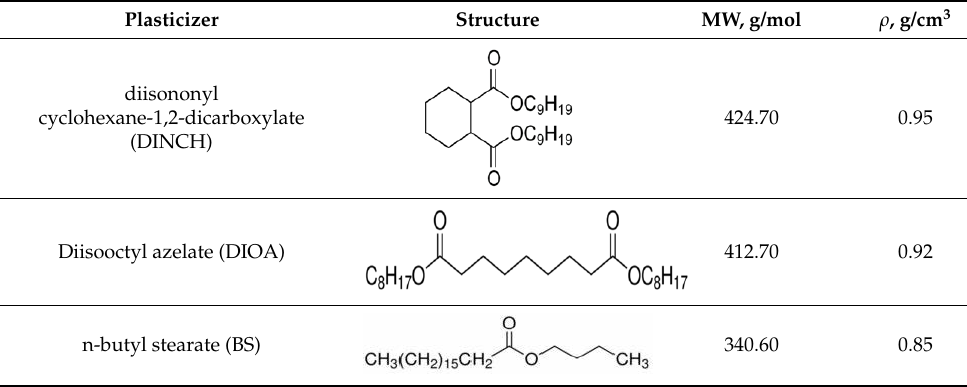
Table 1. Structure and properties of plasticizers used.